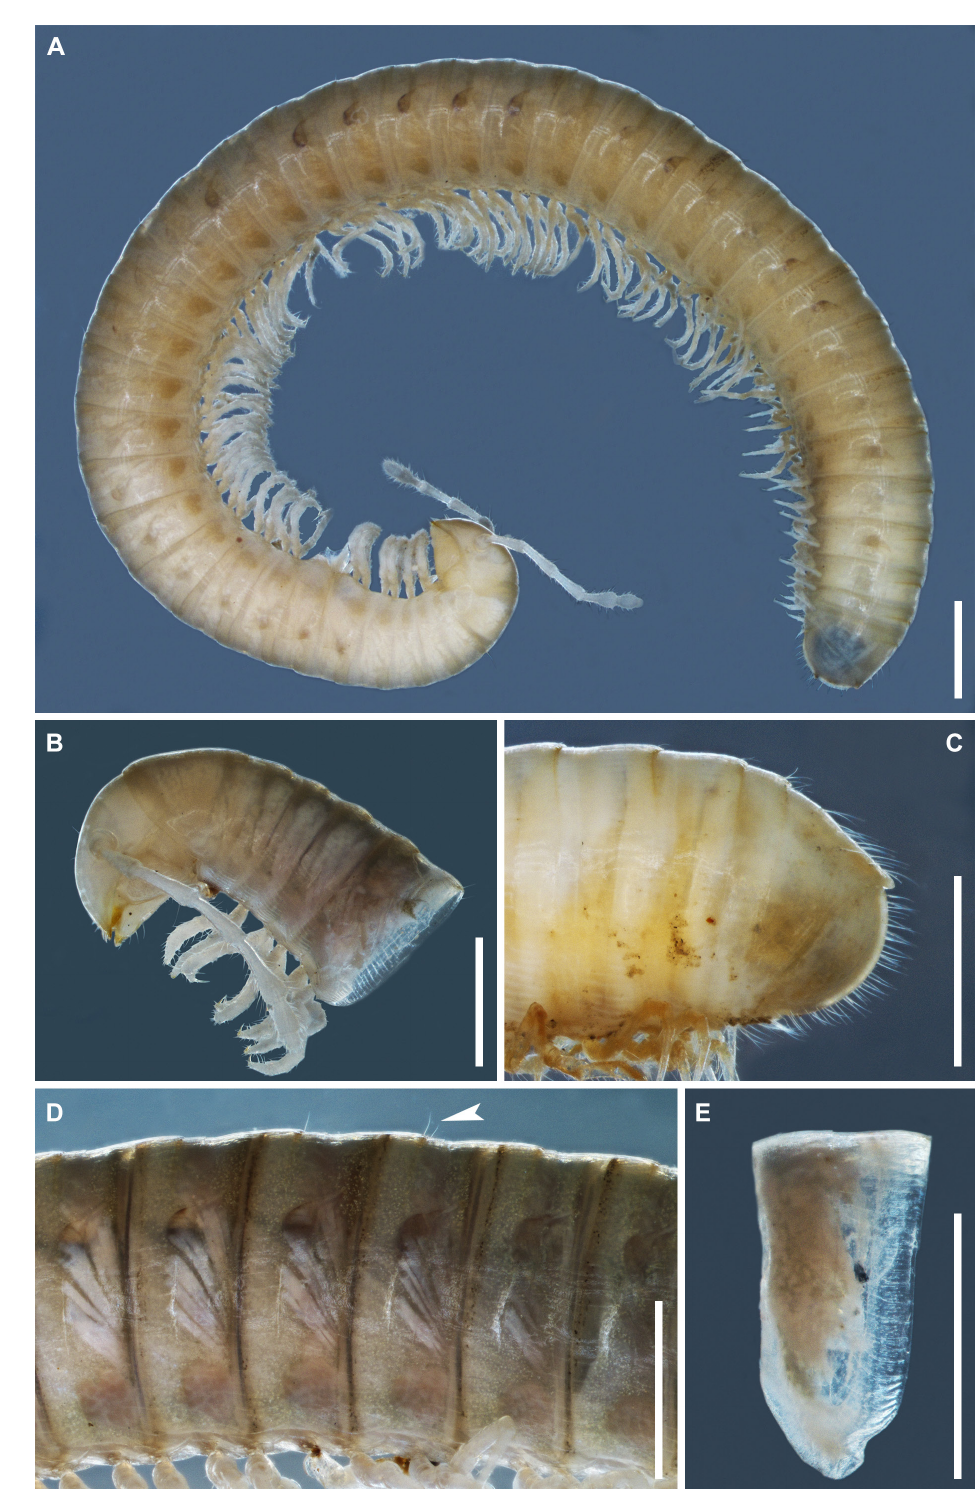
Fig. 25. Leucogeorgia lobata sp. nov., type ♂♂. A . Holotype from Kalitshona Cave, habitus, lateral view (ZMUM). B . Paratype from Garakha Cave, anterior part of body, lateral view (IZISU). C . Paratype from Kalitshona Cave, posterior part of body, lateral view (ZMUM). D . Paratype from Garakha Cave, midbody rings, lateral view (IZISU). E . Paratype from Garakha Cave, body ring 7, lateral view (IZISU). Arrow indicates metazonal setae. Scale bars: 1